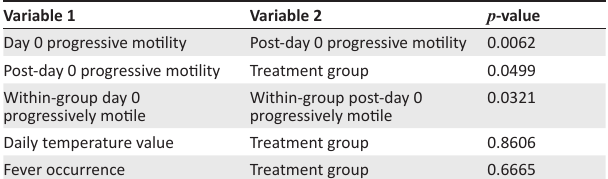
TABLE 5: Summary of correlations between measured variables: single variable